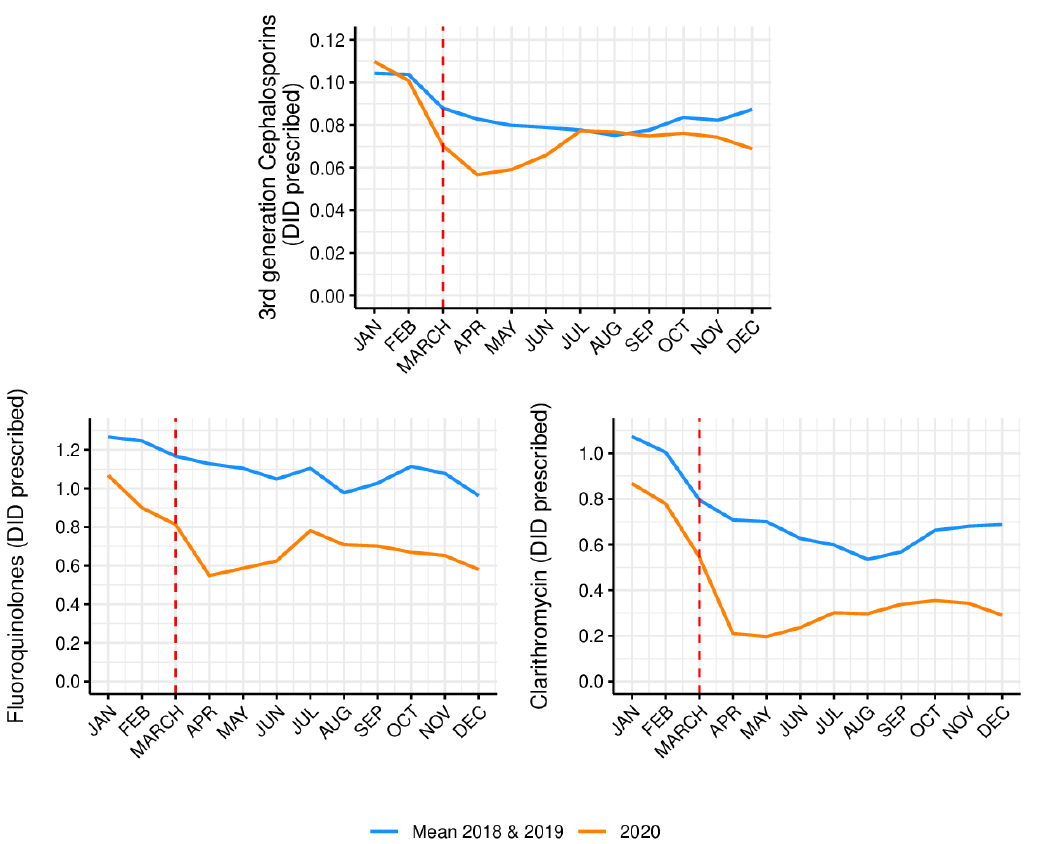
Figure 7. Changes in the monthly prescription of several antibiotic groups and clarithromycin as DID in outpatient care, before and after COVID-19 emergence.